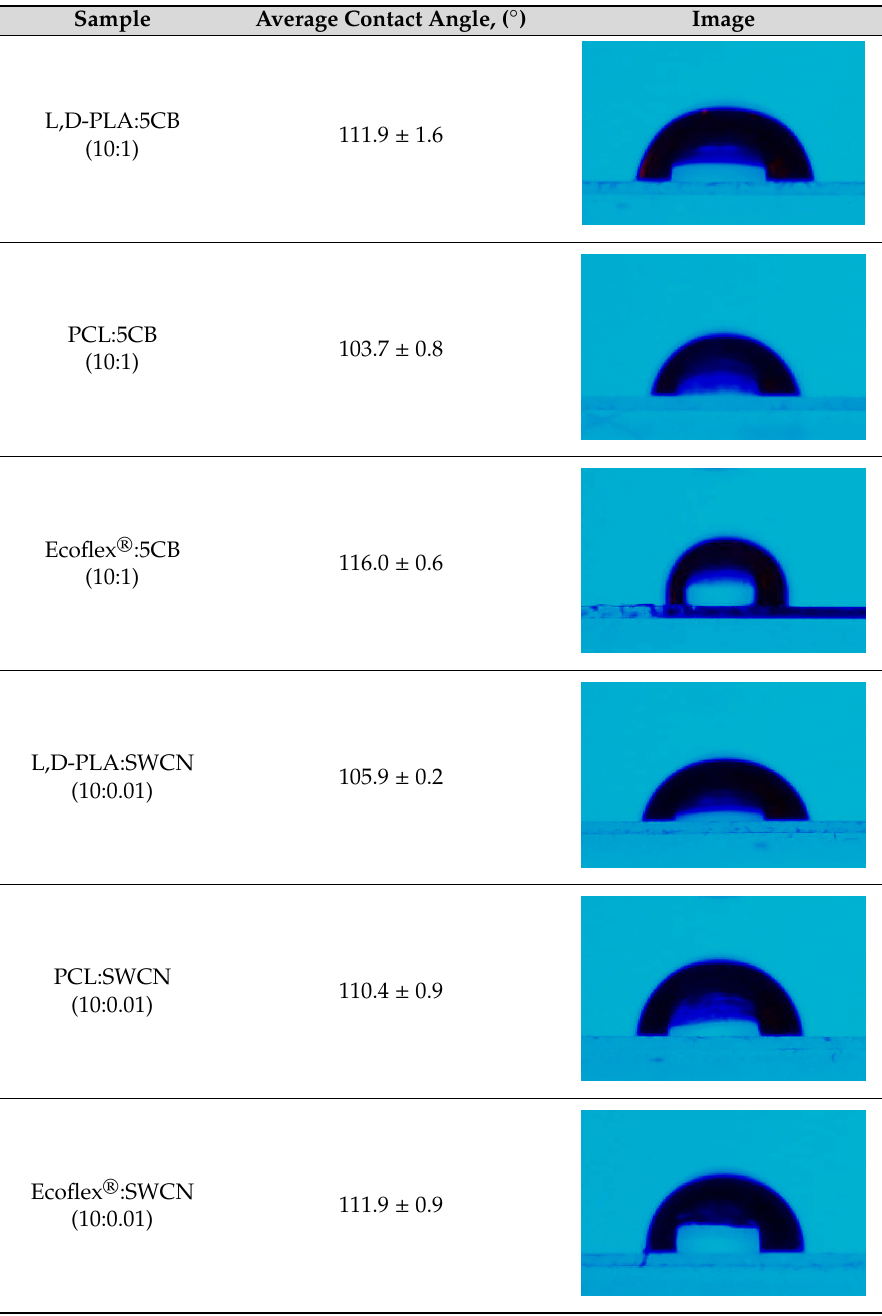
Figure 7. Selected images for the absorption process of water drop by the Ecoflex ® layer.